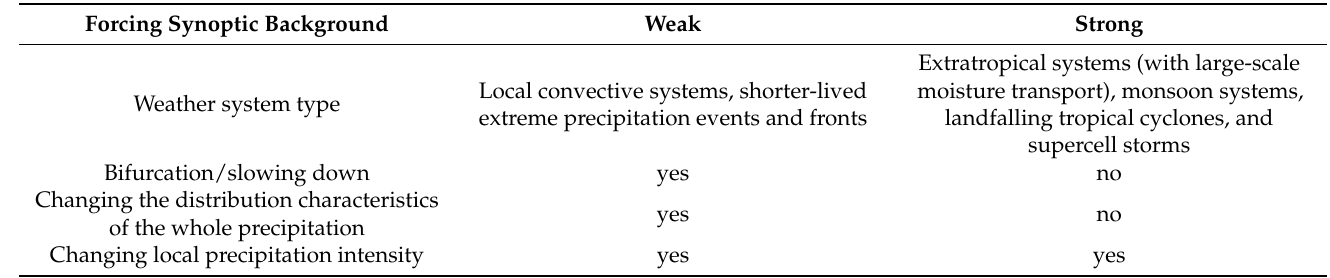
Table 1. Dynamic effects of cities on weather